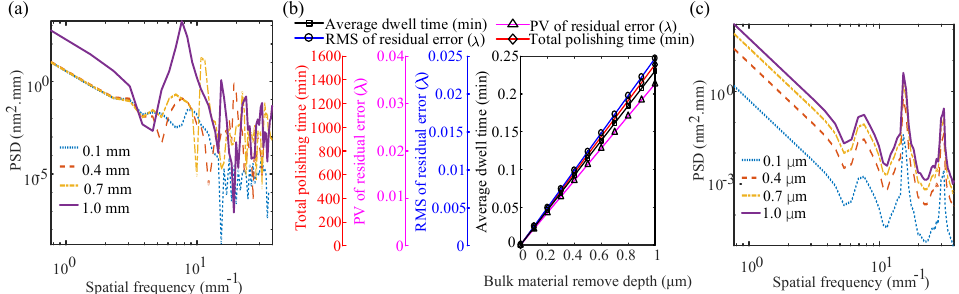
Figure 3. ( a ) y -direction power spectral density (PSD) results for different path pitches; ( b ) influence of the bulk material removal depth on residual error (path pitch = 0.2 mm); ( c ) y -direction PSD results for different path pitches and bulk material removal